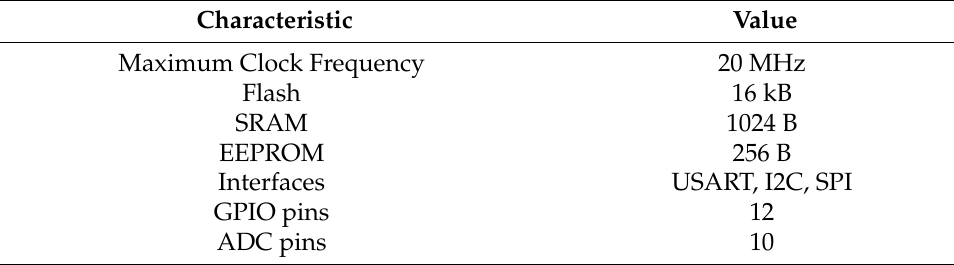
Table 2. ATtiny1604 microcontroller technical